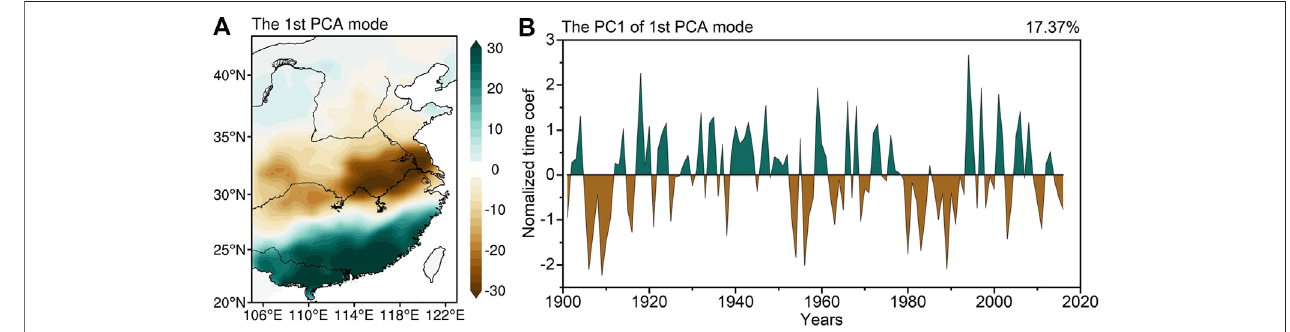
FIGURE2| FirstleadingmodesofSVDfor (A) JJAprecipitationinEC, (C) summersurfacetemperaturefortheperiod of1901 – 2016,andnormalizedtimeseriesof fi rst SVD modes (B, D) . The percentage of total variance explained by the mode is 41.13%.